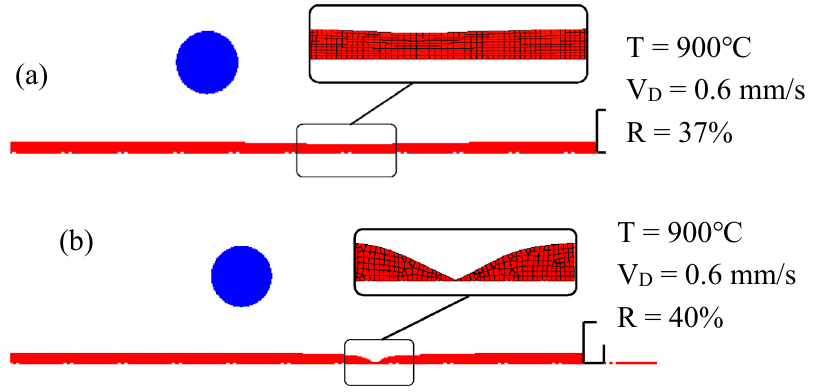
Figure 12. Profiles of drawn wires at different reductions. ( a ) Successful case, ( b ) Failure case.